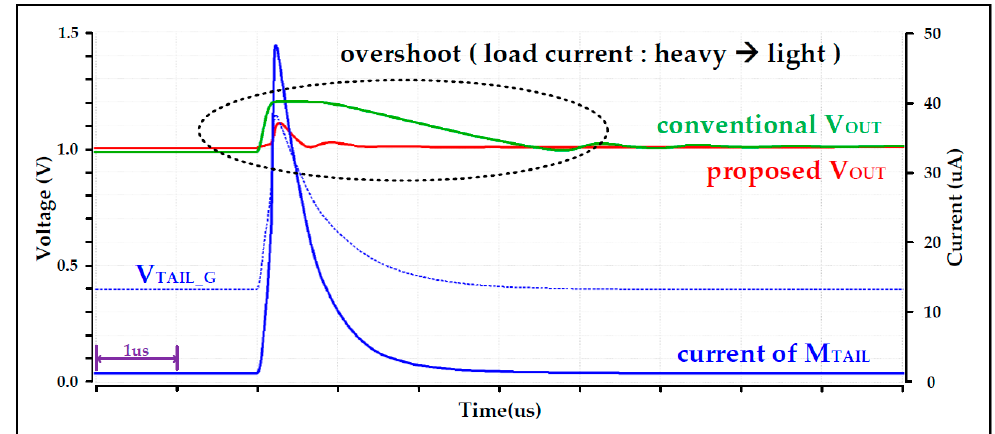
Figure 11. Simulation results of the overshoot tailing reduction filter. (The load current is changed from 100 to 0 mA with 100-ns falling time).